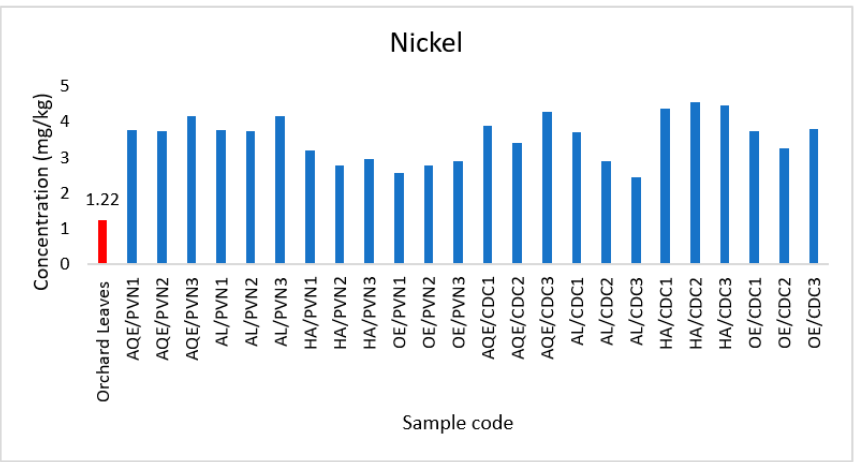
Figure 5. The graph shows Ni concentrations (mg/kg) in extract samples with standard reference material NIST 1571 Orchard leaves.